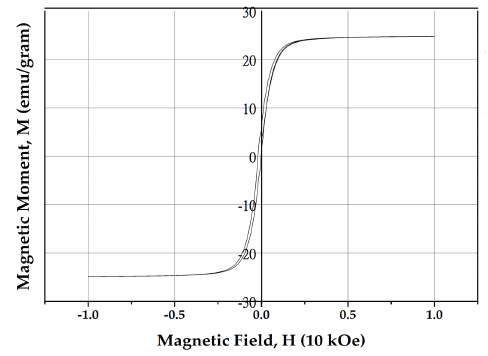
Figure 2. Magnetic hysteresis curve of the extracted sample measured at room temperature.